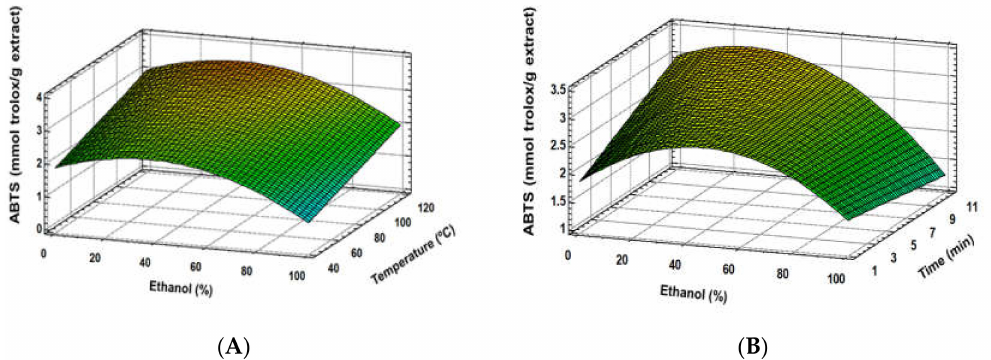
Figure 3. Response surface plots of the ABTS as a ff ected by independent factors; ethanol (%) vs . temperature ( A ), ethanol (%) vs . time ( B